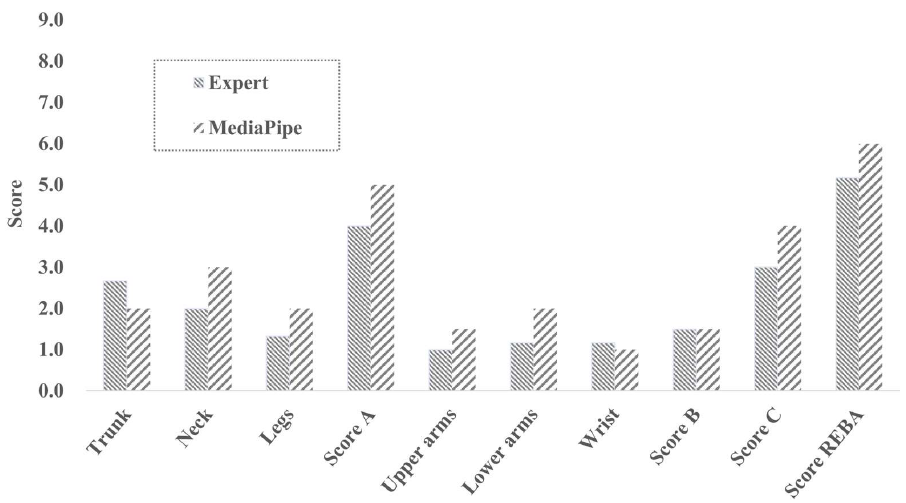
Figure 38. Comparison of saw working posture scores.